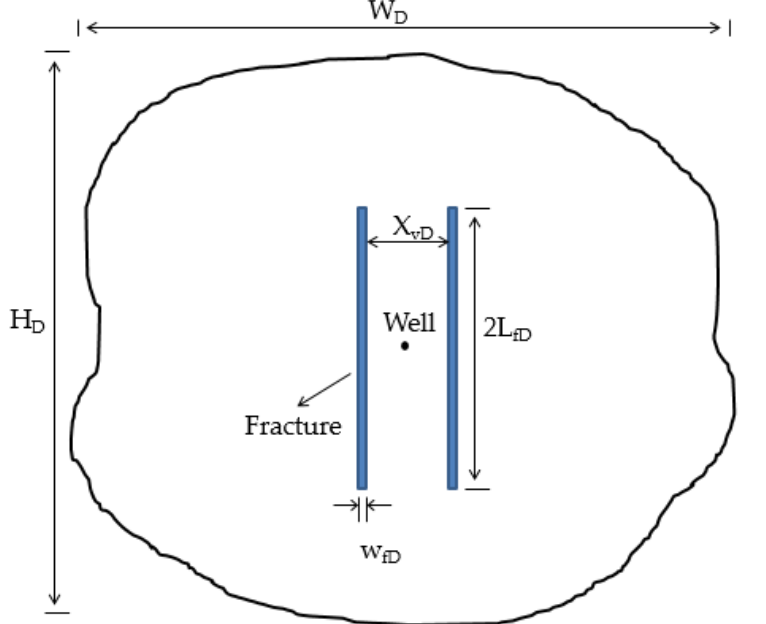
curve is not as sensitive to the geological features of the reservoir. Generally speaking, Figure 6. Reservoir with two parallel, natural, fractures bounded by an arbitrarily shaped outer Figure 6. Reservoir with two parallel, natural, fractures bounded by an arbitrarily shaped outer when pressure-transient hits fault tips, pressure derivative starts to go downward as fluid boundary, with the values of all terms shown, 𝑊 𝐷 , 𝐻 𝐷 , 𝑤 𝑓𝐷 , and 𝑋 𝑣𝐷 may vary. boundary, with the values of all terms shown, W D , H D , w fD , and X vD may vary. beyond the fault tips flows into the channel before the outer no-flow boundary is felt. Figures 7 and 8 show the pressure and the rate behaviors, respectively, when the well